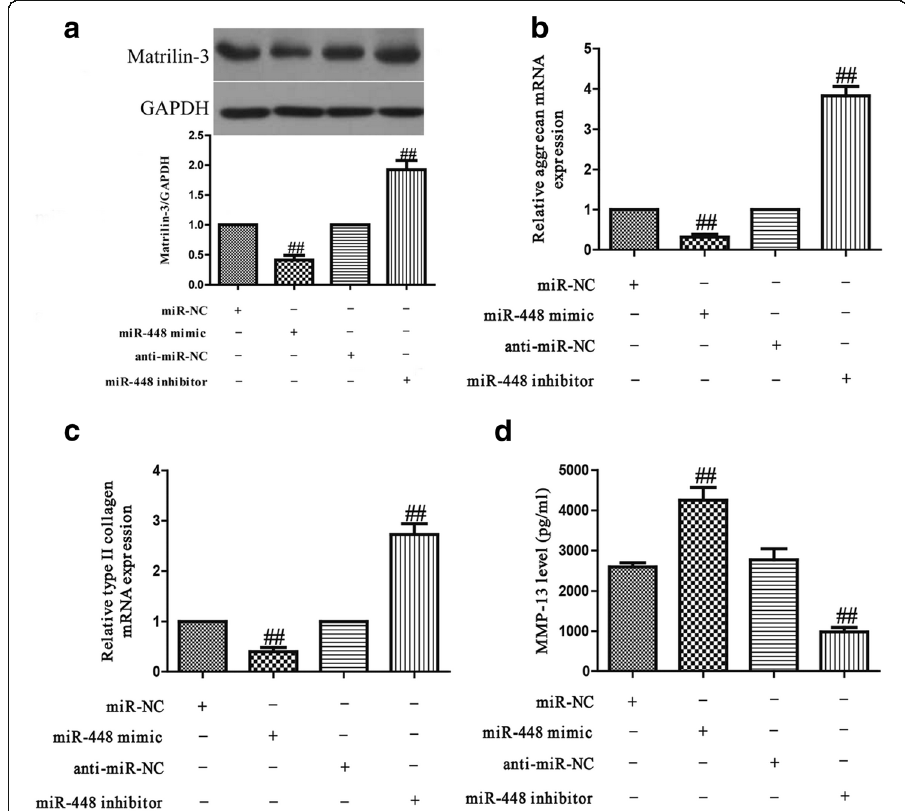
Fig. 6 Effects of miR-448 on osteoarthritis chondrocytes. Osteoarthritis chondrocytes were transfected with miR-448 mimic or inhibitor. a The protein level of matrilin-3 were determined using western blot. The mRNA levels of aggrecan ( b ) and type II collagen ( c ) were determined using quantitative real-time PCR. GAPDH was detected as a loading control. d The expression level of secreted MMP-13 protein was determined using ELISA. All data are presented as means ± SEM, n =4. ## p <0.01 vs. miR-NC or